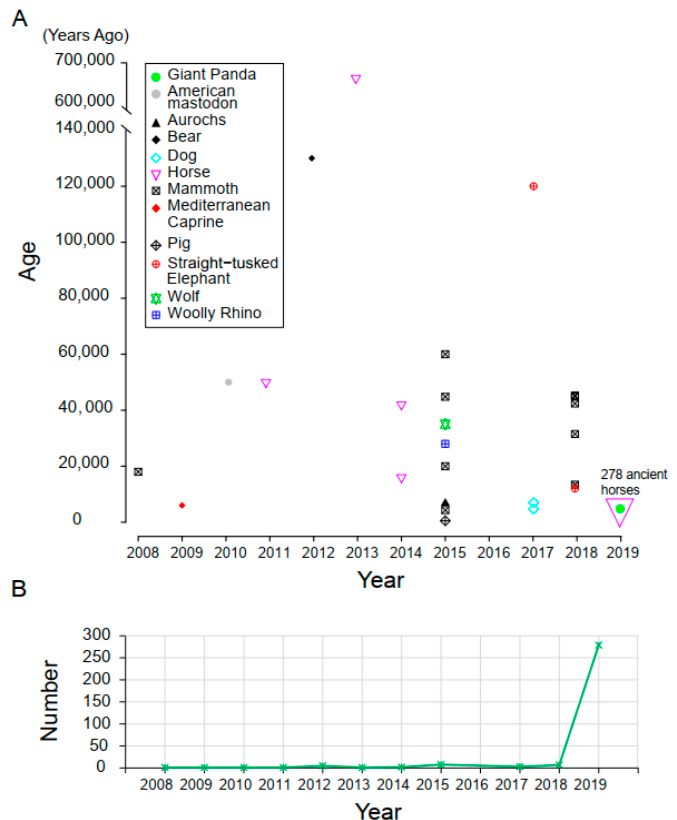
Figure 1. The investigation of whole genome sequenced ancient mammals from 2008 to 2019. ( A ) The species and age of whole genome sequenced ancient mammals from 2008 to 2019. ( B ) The number of whole genome sequenced ancient mammals from 2008 to 2019.